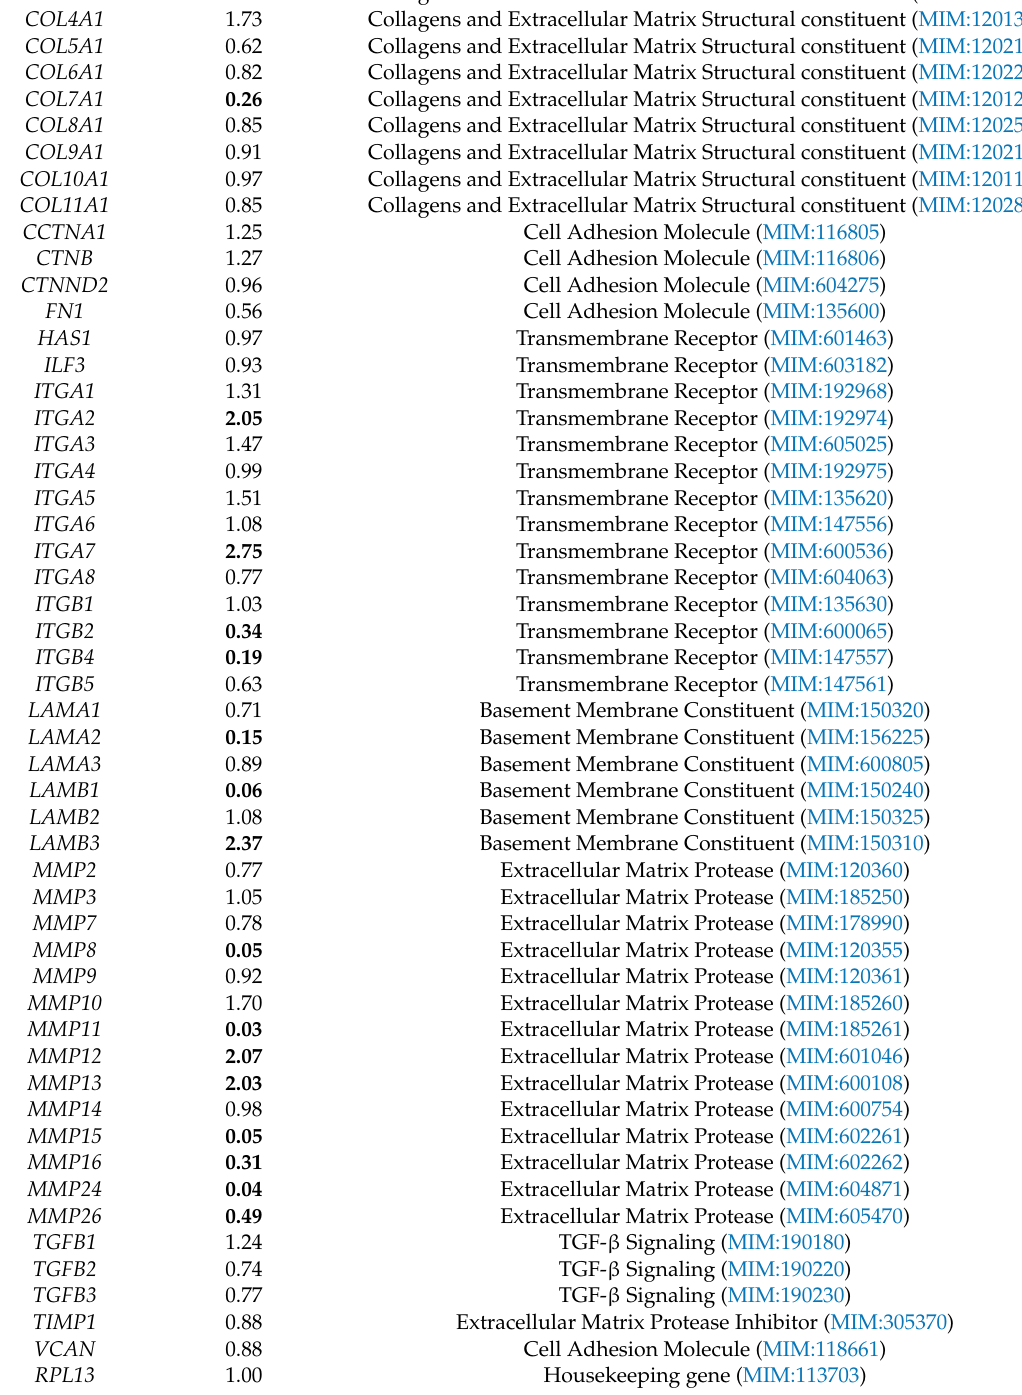
The bold values represent the statistically significant results (fold change ≥ 2 and p-value ≤ 0.05 for upregulated genes, and fold change ≤ 0.5 and p -value ≤ 0.05 for significantly downregulated